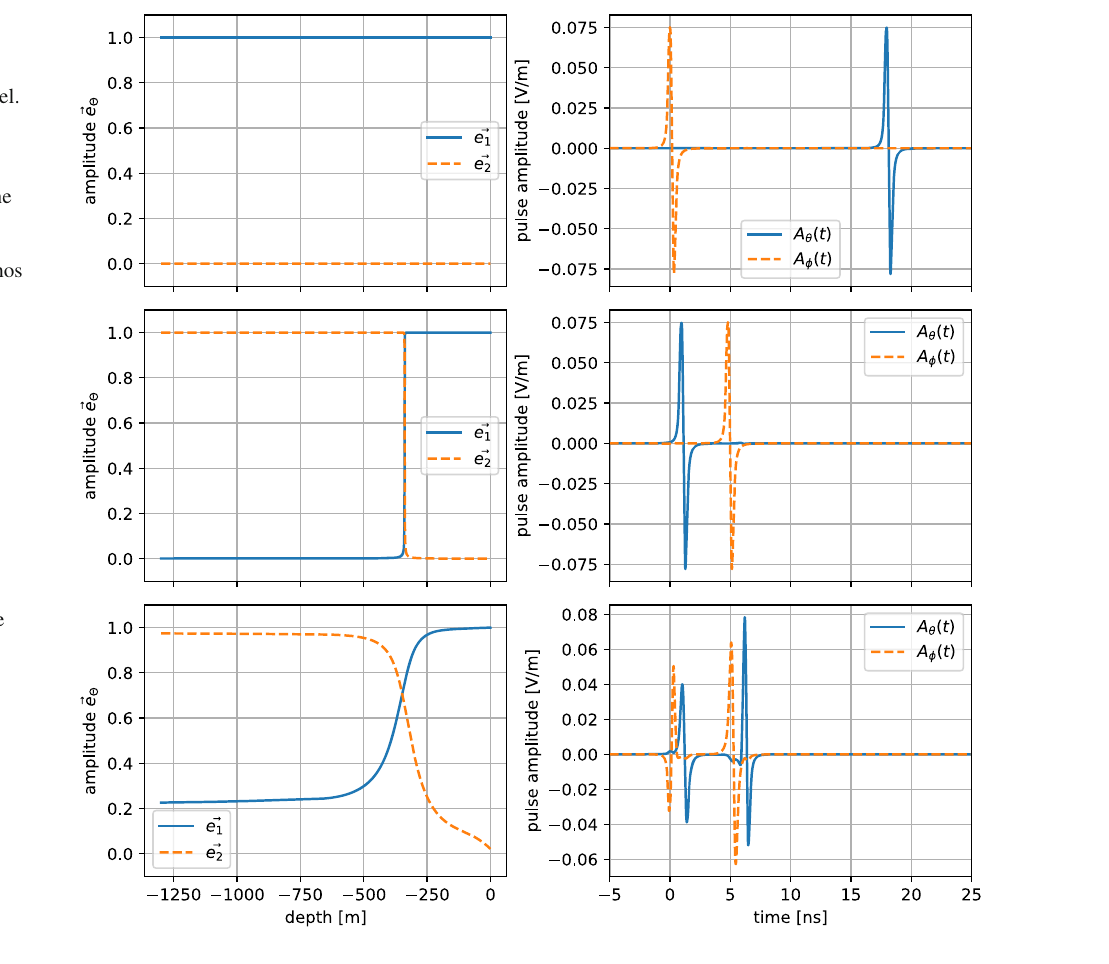
Fig. 13 Measured polarization at the ARIANNA station and the expected polarization after propagating the anechoic chamber pulses throughthebirefringencemodel.Thedifferentbandsindicatethediffer- ent ice models tested in the birefringence model Appendix A. The gray areas mark communication periods during which no data was taken. The SPICE data was averaged over 10m depths, and the 1 σ spread of the distribution is shown with the blue error bars. The light blue shad- ing indicates the systematic uncertainty on the reconstruction stemming fromsystematicuncertaintiesintheARIANNALPDAorientations(see [27] for details)